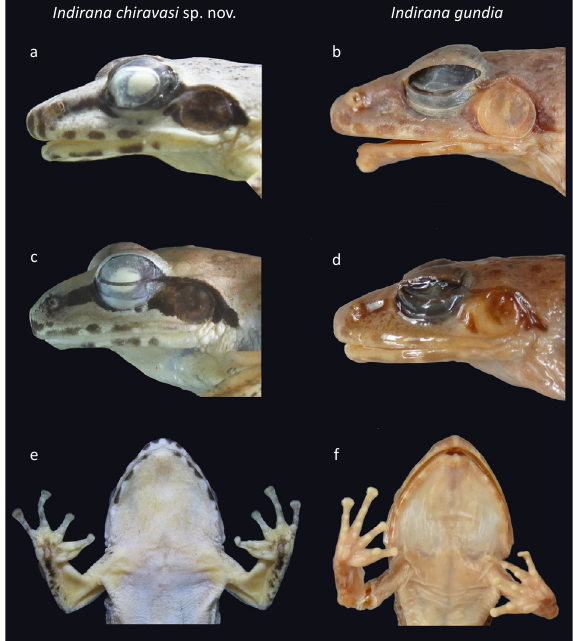
(c) - holotype (BNHS 5888); Indirana gundia : (d) - (male) holotype (MNHN 1985.0633), (e) - (female) paratype (MNHN 1985.0622), (f) - (male) holotype (MNHN 1985.0633). Photo credit: (a-c) Neelesh Dahanukar and (d-f) Nikhil